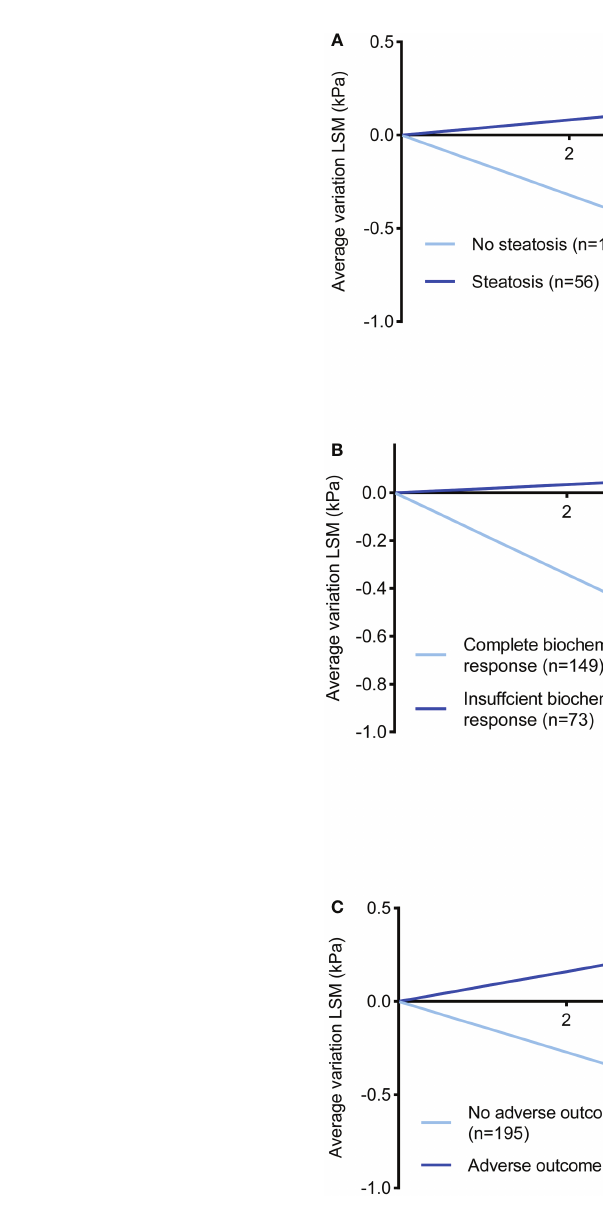
FIGURE 2 Changes in LSM in kPa as a function of time in AIH patients during follow-up (slope: changes in LS per year as percentages from baseline values). (A) With steatosis vs. without steatosis (P < 0.001). (B) Insuf fi cient response vs. complete biochemical response (P < 0.001). (C) Poor outcome vs. no poor outcome (P < 0.001). LSM liver stiffness